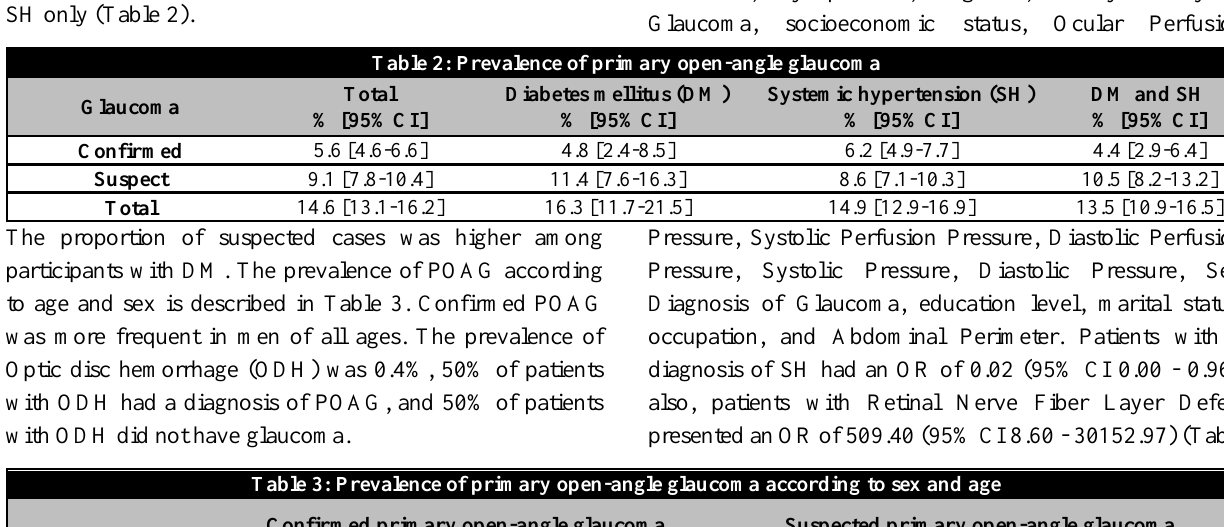
Table 3: Prevalence of primary open-angle glaucoma according to sex and age